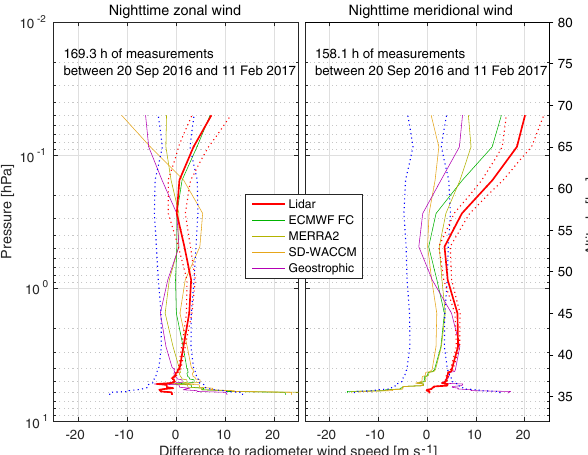
Figure 7. As Fig. 6 but for data from the time period when both instruments were operated in their respective night